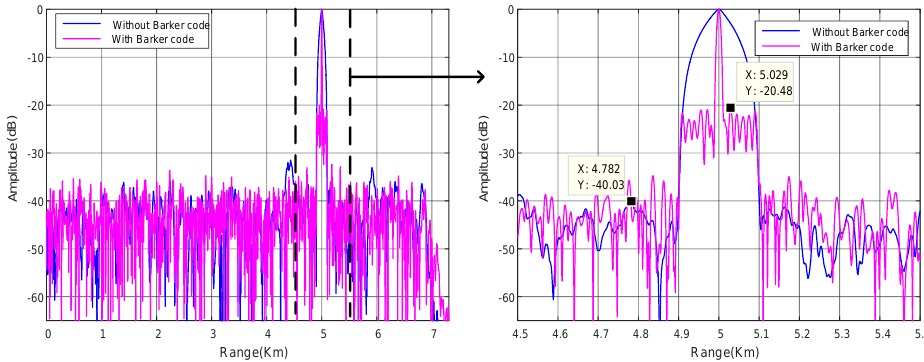
Figure 6. The one-dimensional range profile via space-time matched filtering for θ 1 = 0° and R 1 = 5 km.